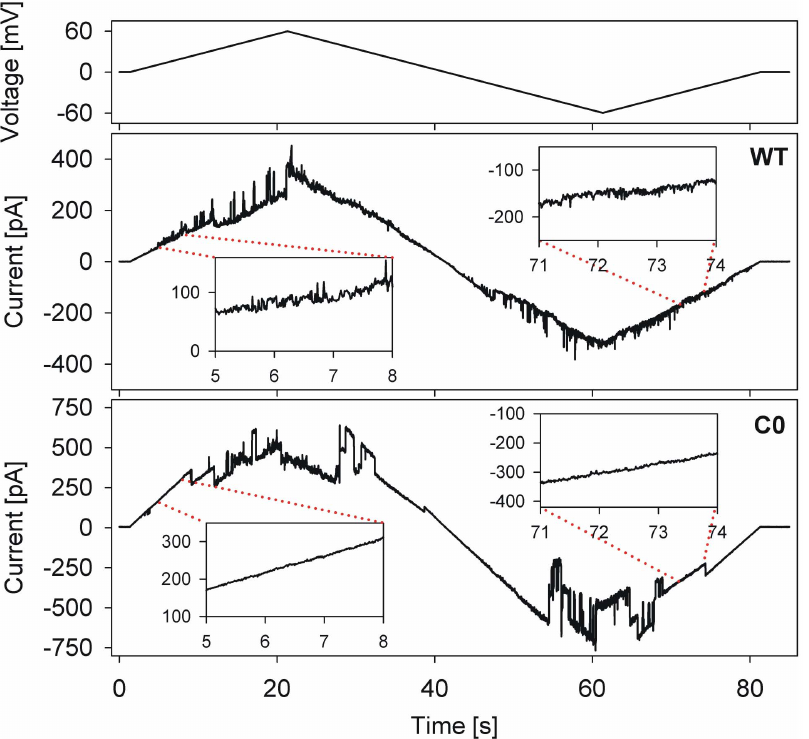
Figure 1. Channel conductance measurements of hVDAC-2 WT and C0 against a voltage ramp. Representative results of voltage ramp experiments that compare the channel conductance of full-length hVDAC-2 WT and C0 protein. The upper panel shows the applied voltage ramp, which ranges from + 60 mV to –60 mV over a period of 84 s. The response of hVDAC-2 WT (middle panel) and C0 (lower panel) are shown. The steep slope of the conductance at lower voltages corresponds to the open state of the channel while the shallower slopes at higher voltages correspond to the closed state of the hVDAC-2 channel. In both the cases presented here, the membrane had , 3–4 active channels.Representative segments of the traces are expanded in the insets to highlight the difference in noise levels of both proteins.